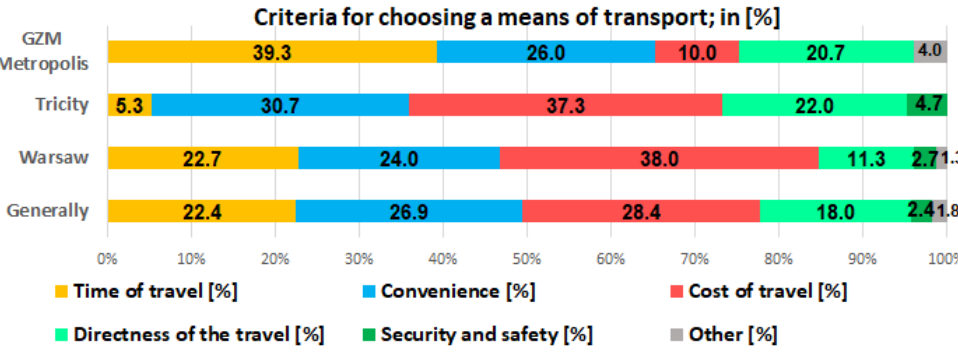
Figure 1. Criteria for choosing a means of transport. Source: based on [3].